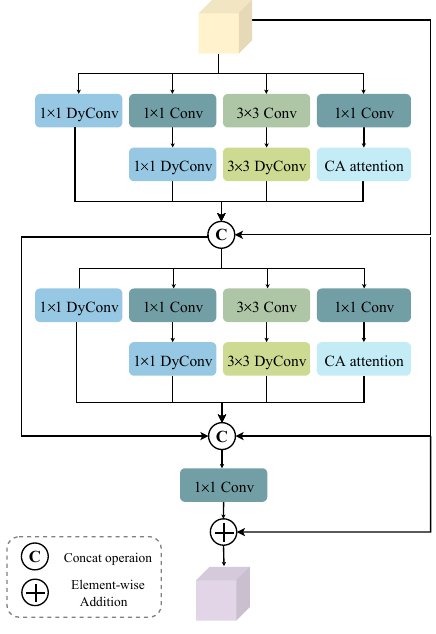
Figure 3. Structure of